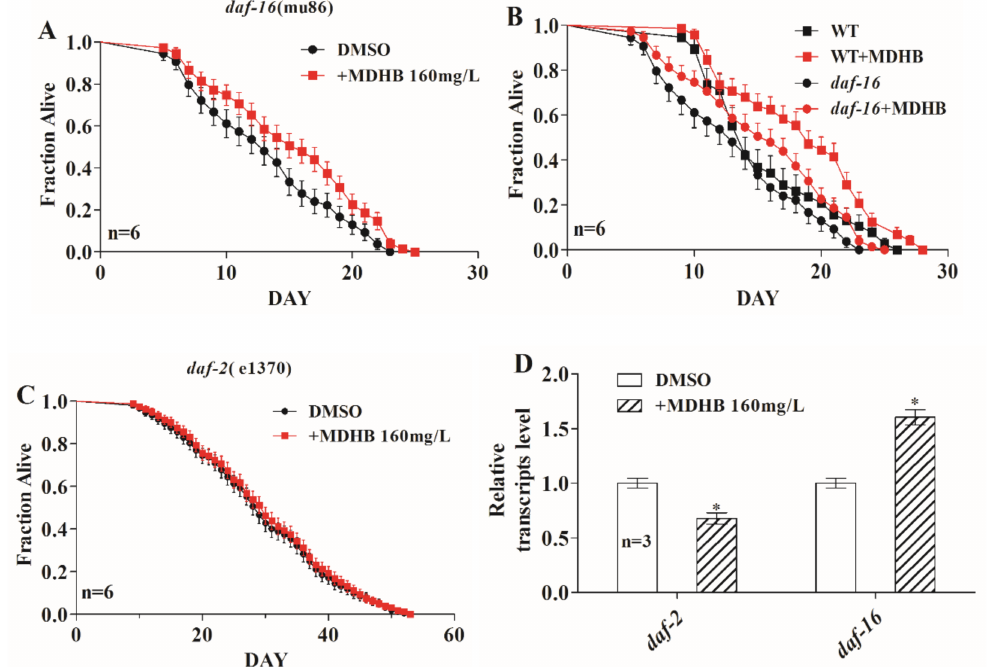
Figure 6. Effects of MDHB on the lifespan of daf-2 and daf-16 loss-of-function mutants. ( A ) Effects of MDHB on the lifespan of daf-16 (mu86) mutations. ( B ) Effects of MDHB on the lifespan of Wild-Type (WT) animals and daf-16 (mu86) mutants. ( C ) on the daf-2 (e1370) mutants. ( D ) Quantification of MDHB exposure on the expression levels of daf-2 and daf-16 by RT-PCR (real-time polymerase Chain Reaction) in wild-type nematodes. Error bars represent the standard deviations (SD), and differences between the DMSO (control) and MDHB groups were described significant at * p < 0.05 by one-way ANOVA. actin -1 was used as an endogenous control, and the mRNA expression were determined by real-time PCR using the 2 − ∆∆ C t method, * p <